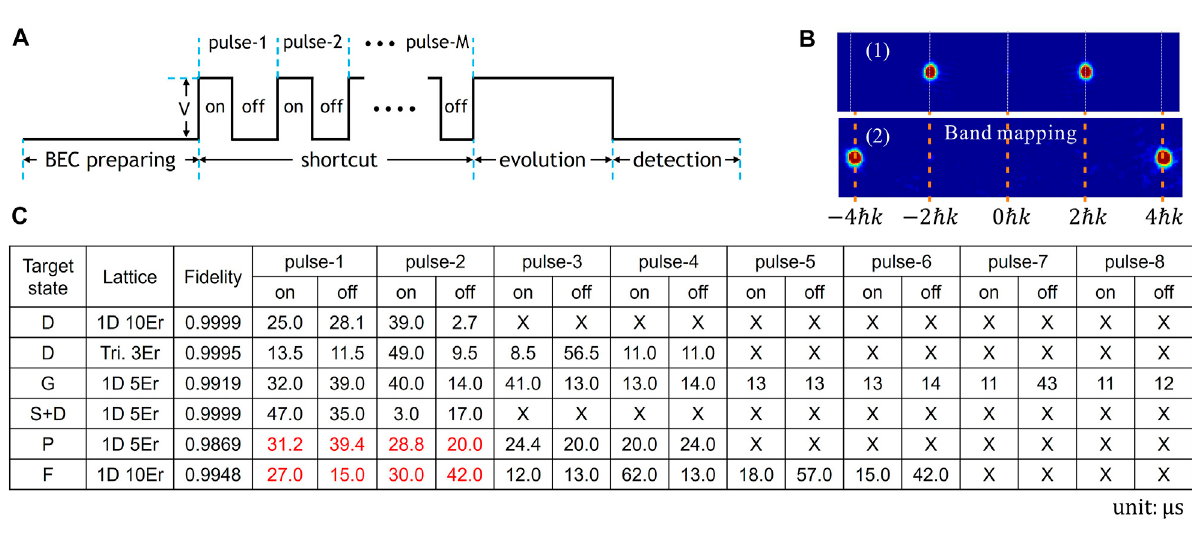
FIGURE 3 (A) The timing diagram of the shortcut. (B) The band mapping result of D-band (top) and G-band (bottom) with zero quasi-momentum for 1D optical lattice. (C) The parameters of shortcut for different target states and optical lattice. The red time parameter is for the sequence of misplacement lattice for the P-band and F-band sequences. The quasi-momentum of all target states in this fi gure is zero. This symbol X indicates that there is no